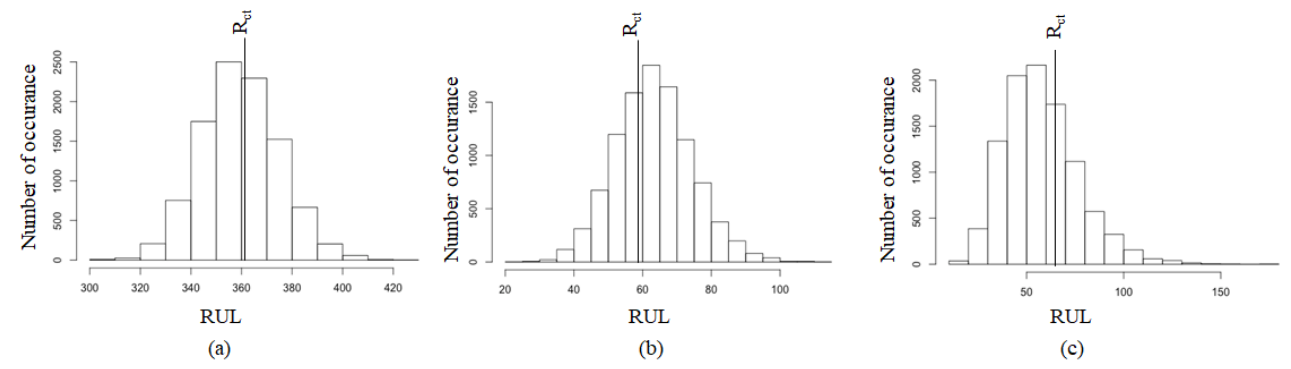
Figure 16. Position of the real crossing time R ct compared to the histograms of RUL for real data with the NN algorithm: